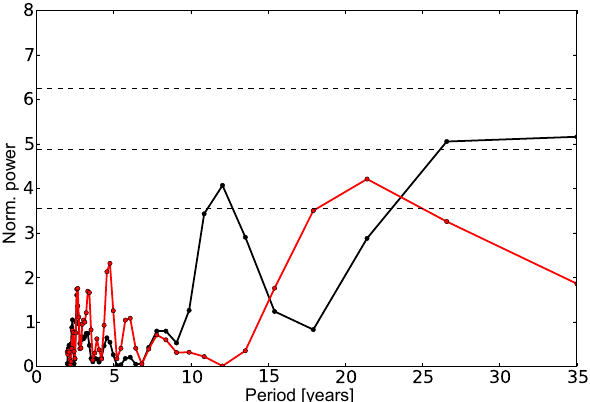
Figure 7. The Lomb–Scargle periodogram for the time series of an- nual OH ∗ temperatures (see Fig. 1 lower panel) is shown in black and the LPS for the residual after subtracting the fit according to Eq. (3) (see Fig. 6 lower panel) is shown in red. The LSP is evalu- ated at 53 evenly spaced frequencies in the range f = 1 / 2year − 1 to f = 1 / 35year − 1 . The dashed black horizontal lines display the lev- els for false alarm probabilities of 0.01, 0.1, and 0.5 (top to bottom). The false alarm probabilities are calculated according to Eq. (2) us- ing N i = 32 . 4 and the number of data points N =